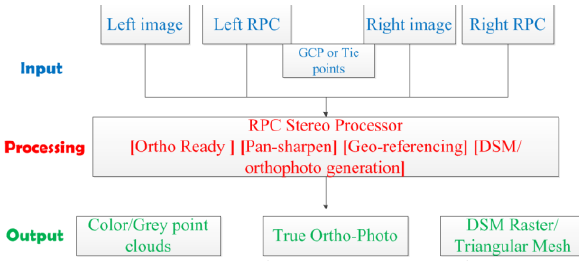
Figure 2. Input-output functioning diagram of RSP